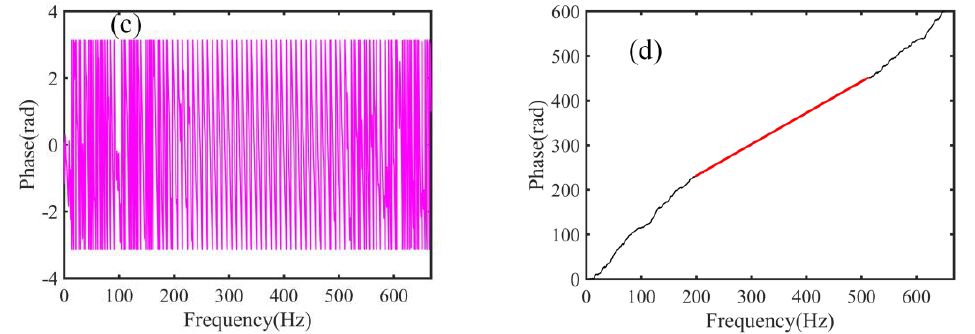
Figure 7. Fourier transform data process. ( a ) Data after the sub sampling; ( b ) frequency spectrum of Fourier transform; ( c ) wrapped phase of Fourier transform; ( d ) unwrapped phase of Fourier transform.